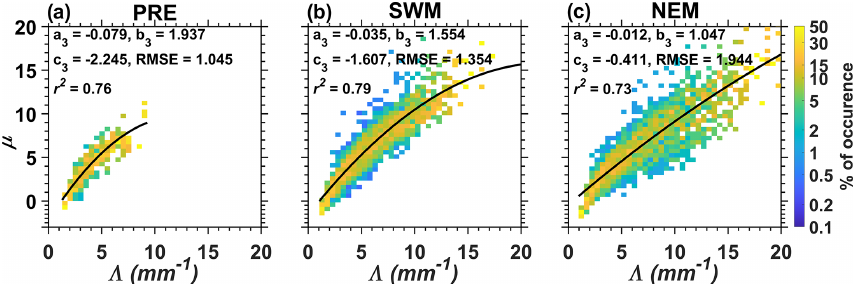
Figure 3. Scatter plots between µ and (cid:51) during the (a) PRE, (b) SWM and (c) NEM seasons. The color indicates the percentage occurrence of data in each cell. The power law regression fit is overlain (solid line) on the data. The statistics of regression fits are also depicted in each panel of the